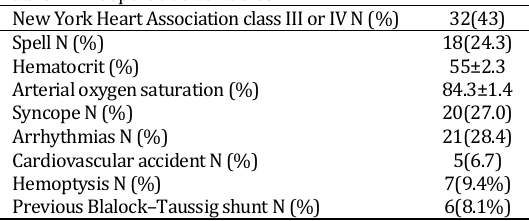
Table 2. Preoperative variables New York Heart Association class III or IV N (%)